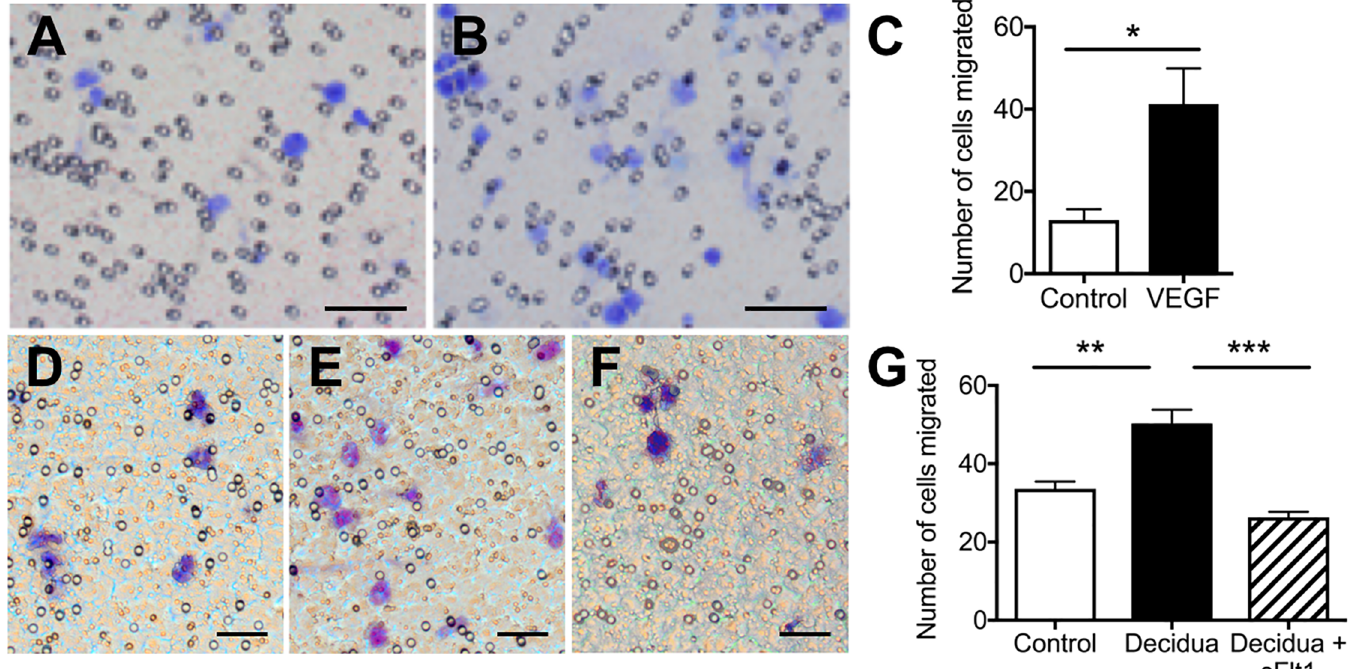
Fig 5. VEGF produced by decidualized endometrial stromal cells stimulate macrophage migration. A-C, transwell migration assay showing migration of M0 cells without (A) or with (B) VEGF treatment (2 μg/mL). Bar graph (C) shows quantitative estimation of the number of migrated cells. Addition of VEGF to the medium in the lower chambers induced about a 3-fold increase in migration of cells (B and C). D-G, transwell migration assay of M0 cells; D, treatment with non-decidualized stromal cell-conditioned medium; E-F, treatment with decidualized stromal cell-conditioned medium in the absence (E) or presence (F) of the VEGF inhibitor sFlt1; G, quantification of migrated cells. Note that decidualized stromal cell-conditioned medium significantly stimulated migration of M0 cells (E and G) but the effect was completely abrogated by the addition of sFlt1 (F), suggesting that VEGF secreted into the conditioned medium may play a role in stimulating the migration of these cells. Graphs represent means ± standard errors; (cid:3) = p < 0.05, (cid:3)(cid:3) = p < 0.01, (cid:3)(cid:3)(cid:3) = p < 0.001. Scale bars represent 50 μm.